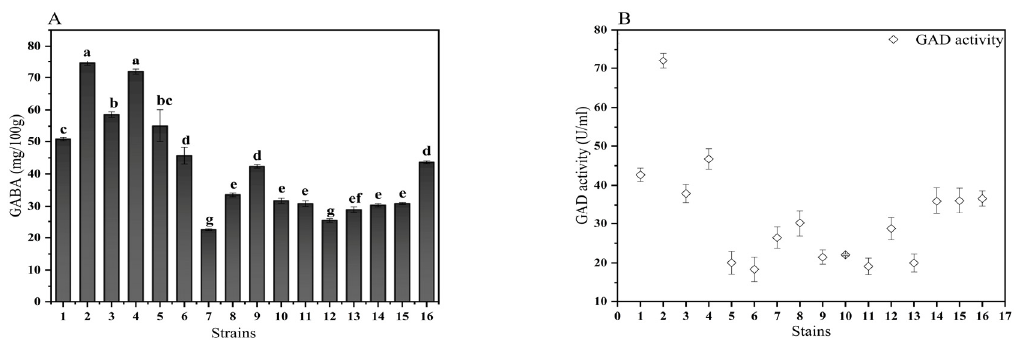
Figure 1. GABA contents of the culture filtrates of the isolates grown in quinoa medium ( A ). Change in GAD activity using different L. plantarum , NO.1-NO.16 ( B ). GABA: γ -aminobutyric acid; Native: native quinoa flour; CQ − 4: quinoa flour cold stress treated at 4 °C; CQ − 20: quinoa flour cold stress treated at − 20 °C. Results are expressed as the mean ± standard deviation. Different lowercase letters indicate significant differences ( p < 0.05) between different strains.